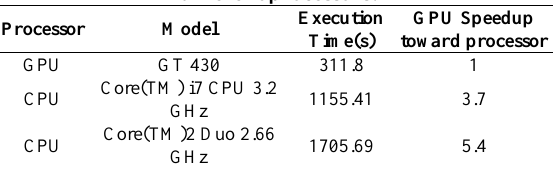
Table 4. Recognition execution time comparing between different